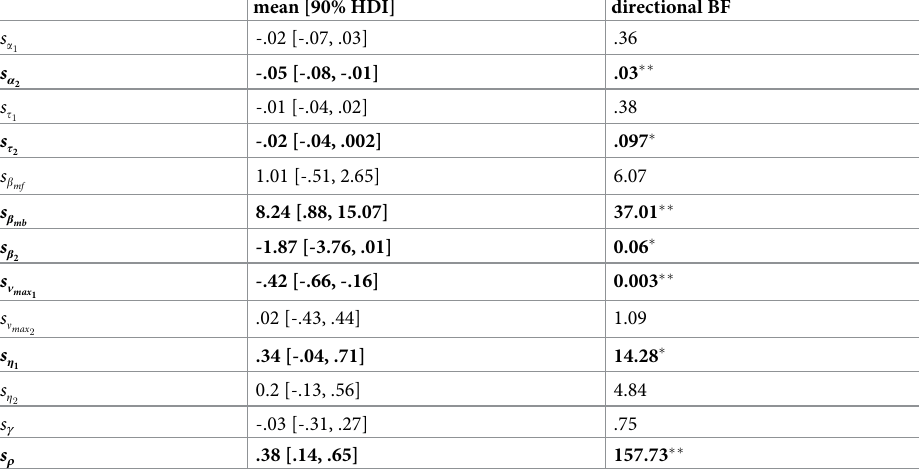
Table 3. Tyrosine related changes in group-level means of the DDM s for the seq. reinforcement learning data. We report mean (and 90% HDIs) for the ‘shift’ parameters modeling tyrosine-related effects, and Bayes Factors for directional effects (tyrosine > placebo). � ( �� ): Strong evidence (dBF > 10 / < .1) for a tyrosine-related effect (& 90% HDIs outside of